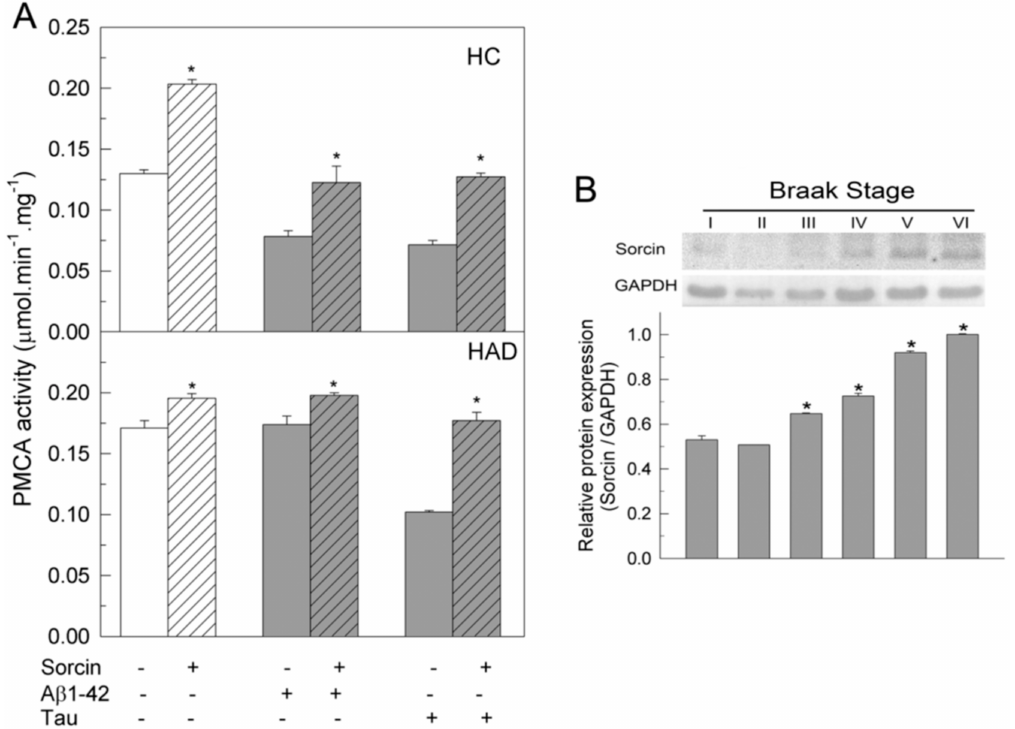
Figure 5. ( A ) Sorcin prevents the inhibition of PMCA activity by A β and/or tau in membranes from human control (HC) and AD (HAD) brain samples. Ten µ g of membranes from HC (Braak stages I and II) and from HAD (Braak stages V and VI) were incubated without (plain bars) or with (stripped bars) 1 µ M sorcin and 30 µ M A β 1-42 or 300 nM tau (grey bars) in 25 µ L, and then diluted up to 1 mL with assay medium plus 0.01% saponin. PMCA activity was assayed after triggering the reaction with 1 mM ATP, as indicated in the Methods Section. Data represent mean ± SE values of three experiments performed with four preparations of each Braak stage. * p ≤ 0.001 vs. MV without sorcin. ( B ) Expression levels of sorcin in human brain samples at increasing Braak stages of AD. Twenty µ g of human brain samples (SN1) of Braak stages I, II, III, IV, V and VI, were electrophoresed into 12% SDS-PAGE gel, electro-transferred to PVDF and immuno-stained with the anti-sorcin antibody, as indicated in the Methods Section. The immunoblot is representative of three assays with at least three samples from each stage. Relative expression of sorcin vs. GAPDH is shown as mean ± SE values (arbitrary units). * p ≤ 0.001 vs. Braak stage